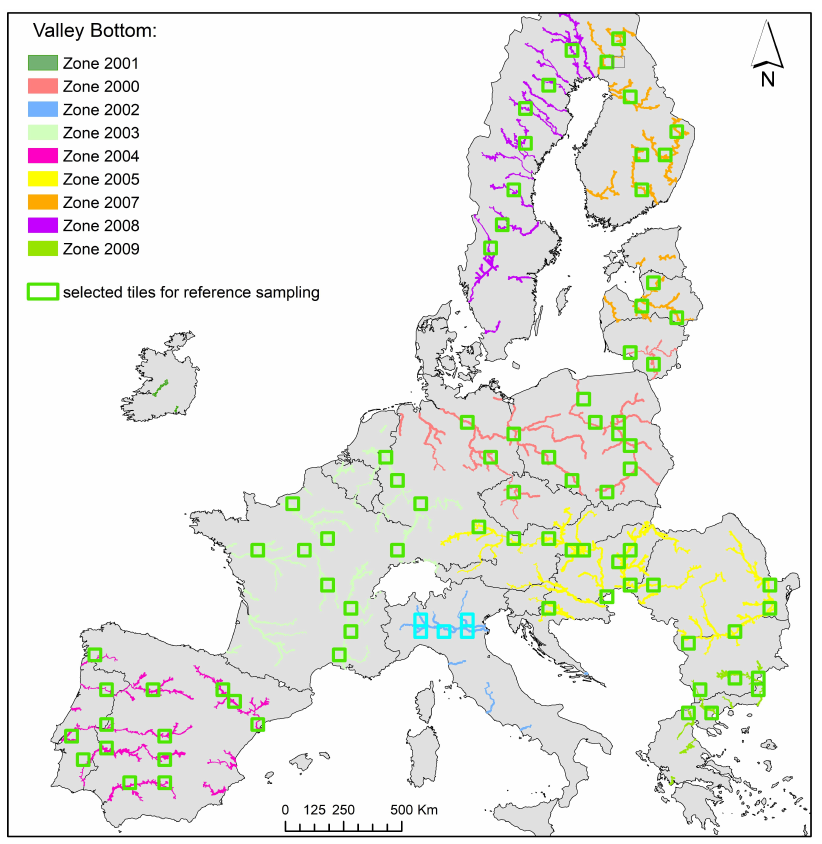
Figure 6. Valley bottom results for each zone analyzed. Randomly selected tiles where collection of training and validation samples was performed are also plotted in green boxes. Table 2. Two-level hierarchical segmentation processing time displayed by zone of